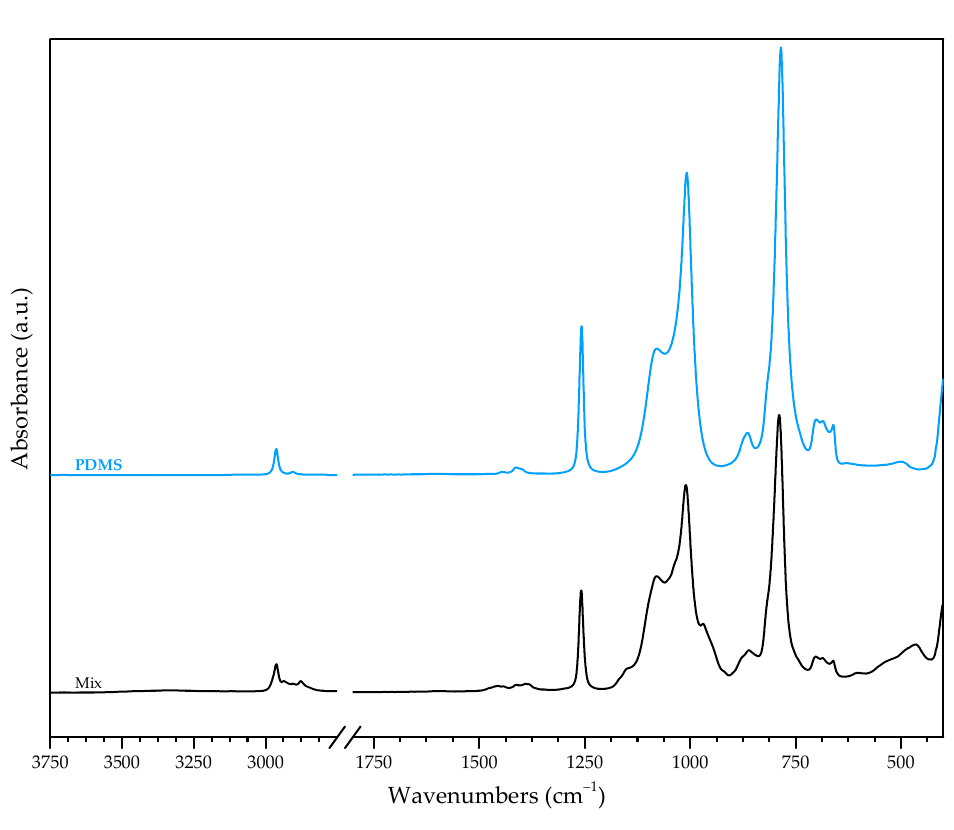
Figure 6. Mix:FTIR spectra of PDMS and Mix. Table 6. Assignment of FTIR bands for precursors, Mix and